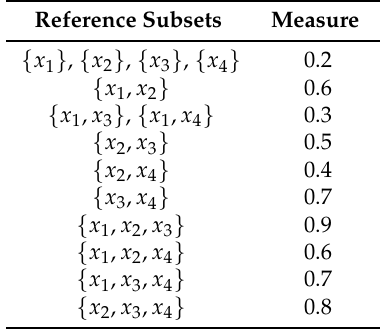
Table 2. A fuzzy measure matching the criteria in Example 5.